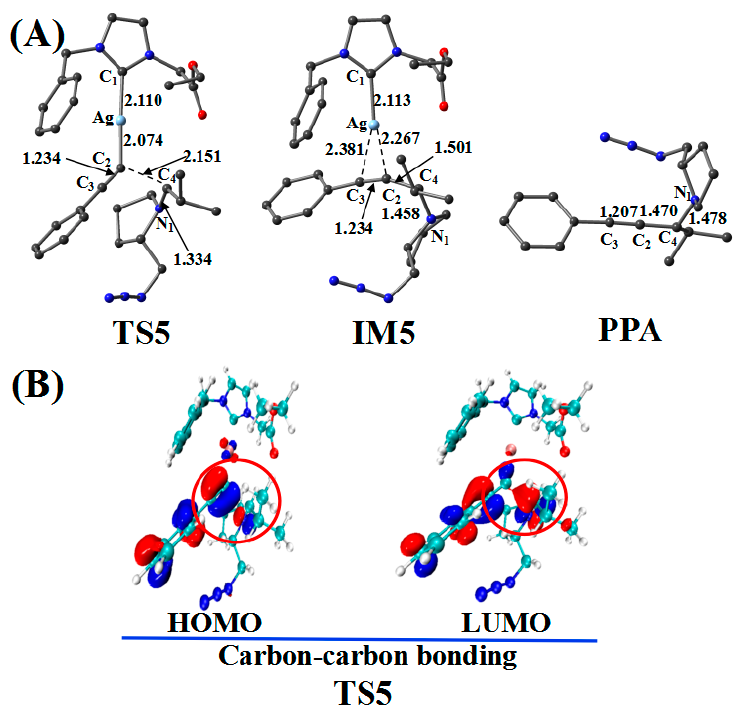
Figure 8. ( A ) Optimized geometries in the reaction pathway of Imine and Ag_PAI; the critical bond length is in Å . Hydrogen atom has been omitted for clarity. ( B ) Frontier orbitals of TS5.